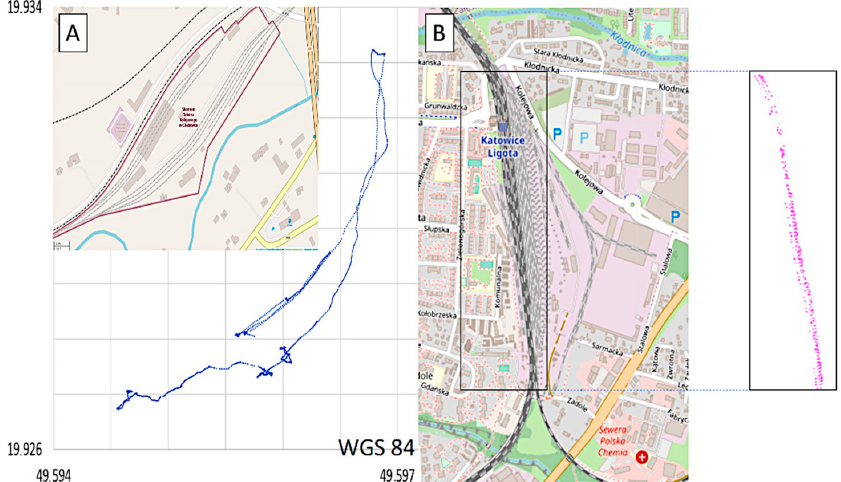
Figure 4. ( A ) /Trace of the locomotive performing shunting activity at the Chab ó wka station ( B ) /trace of EN57 suburban multiple-unit set train at the Katowice Ligota station. Source: OSM/JSOM